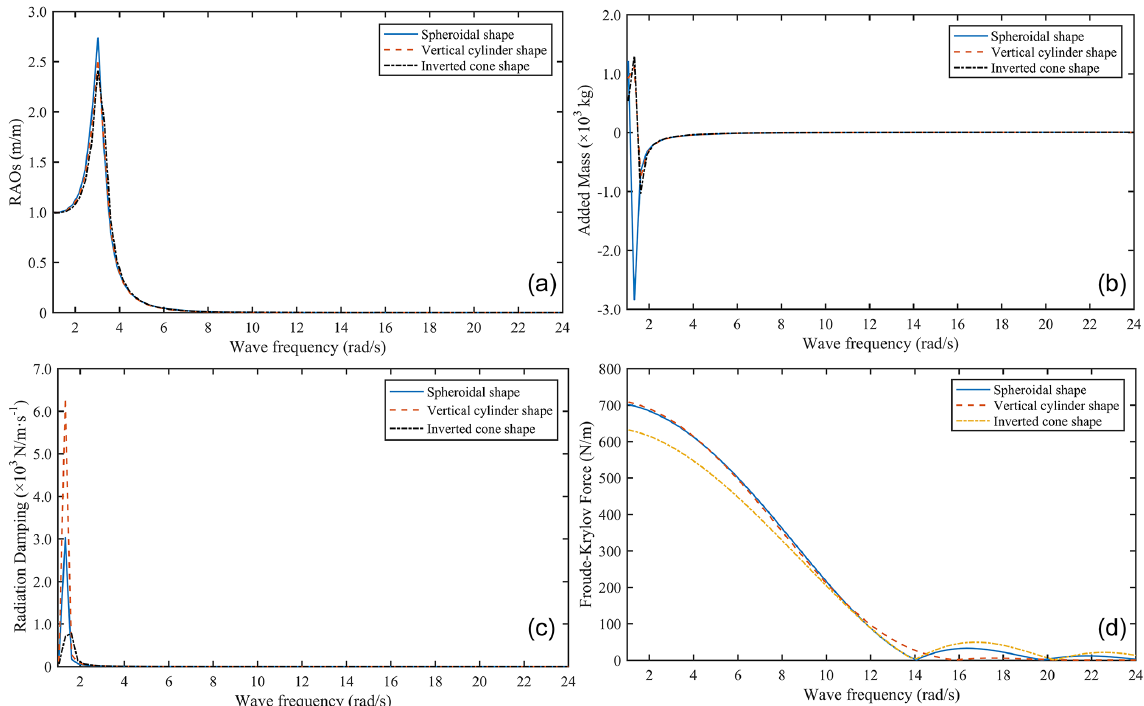
Figure 6. Energy efficiency comparison of floating bodies with the multi-type axisymmetric rotating type. (a) RAOs. (b) Radiation damping. (c) Added mass. (d) Froude–Krylov force.